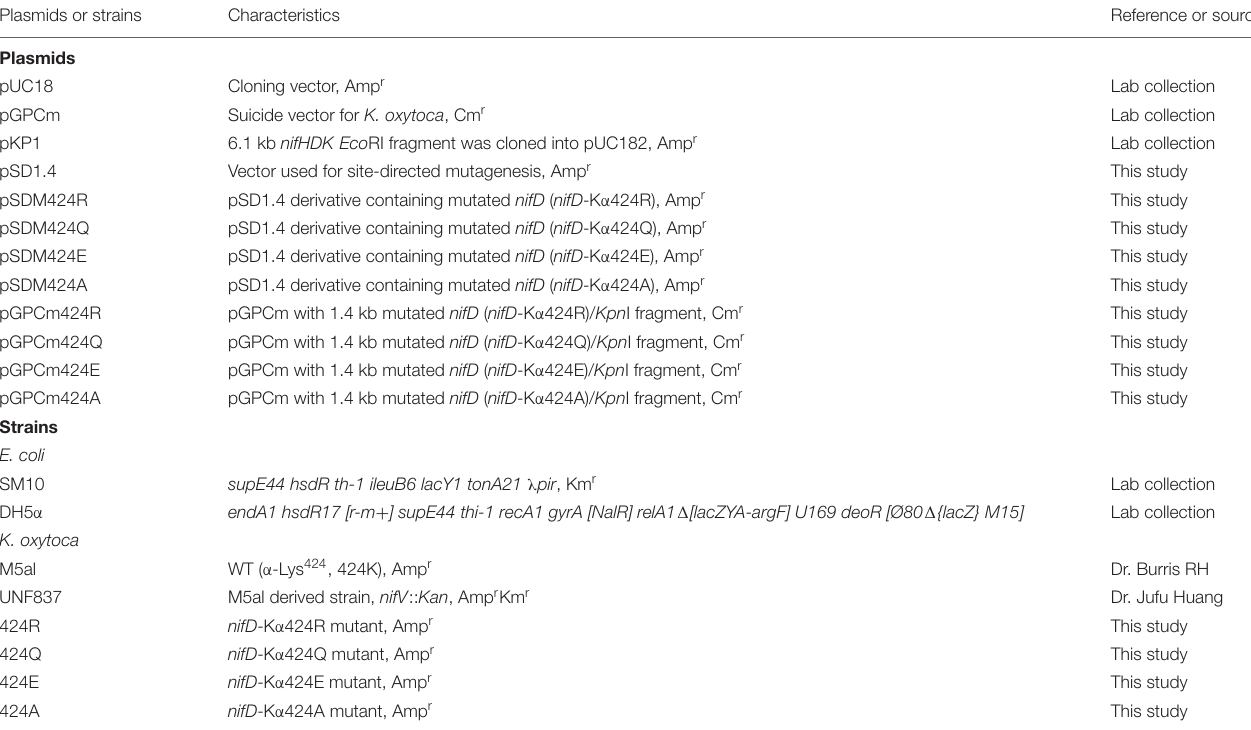
TABLE 1 | Plasmids and strains used in the present work. Plasmids or